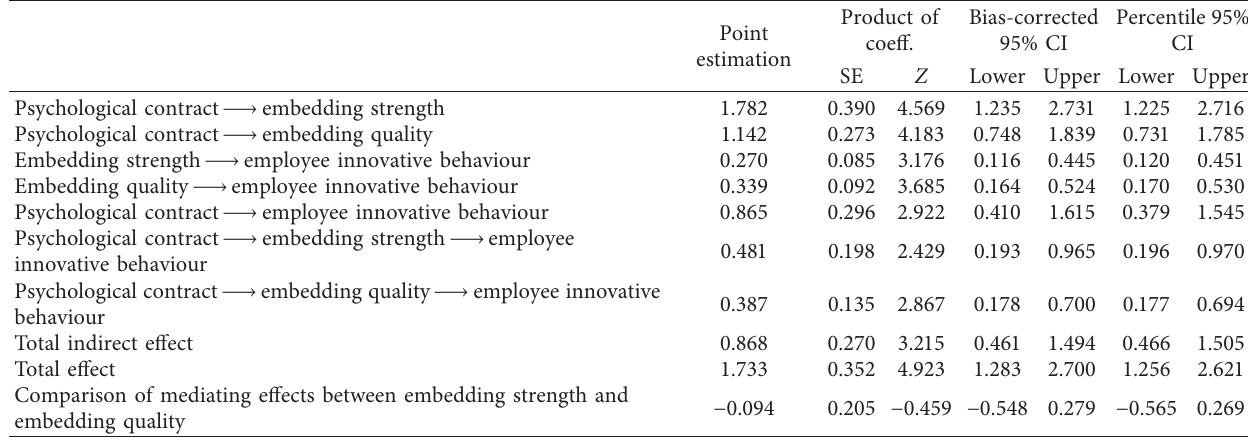
Table 4: The test of intermediary effect.